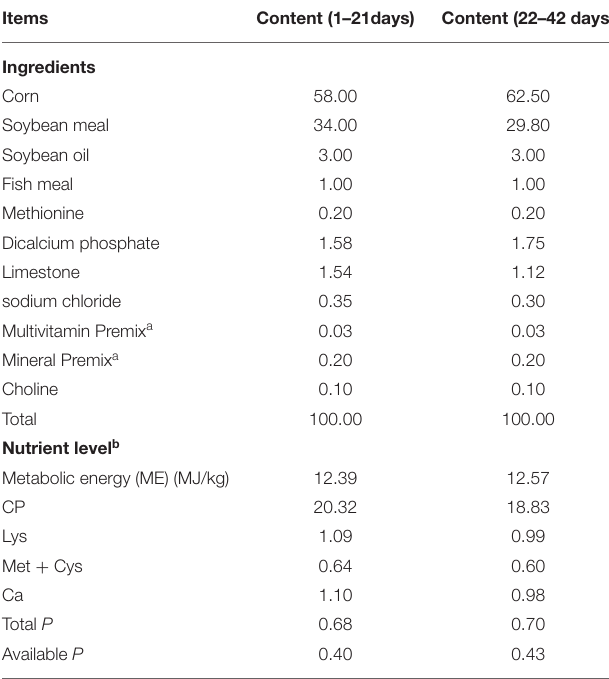
TABLE 1 | Analysis composition of basal diets and nutrient level (air dry basis,